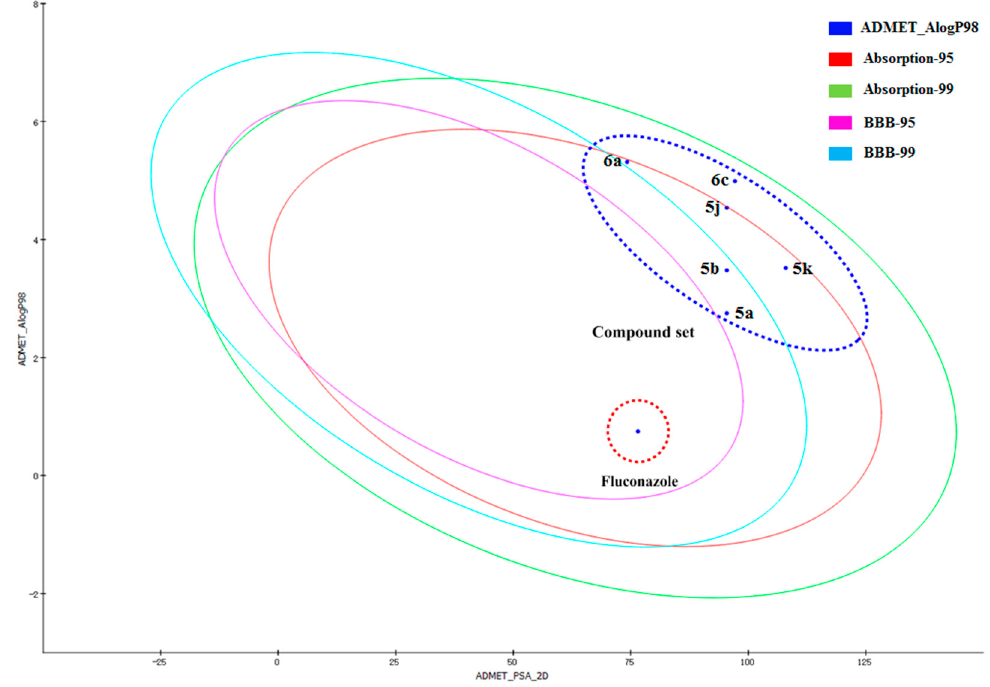
Figure 3. The evaluation chart of Alog P and PSA of target compounds. The 95% and 99% confidence limit ellipses of blood–brain barrier (BBB) and human intestinal absorption (Absorption) models.